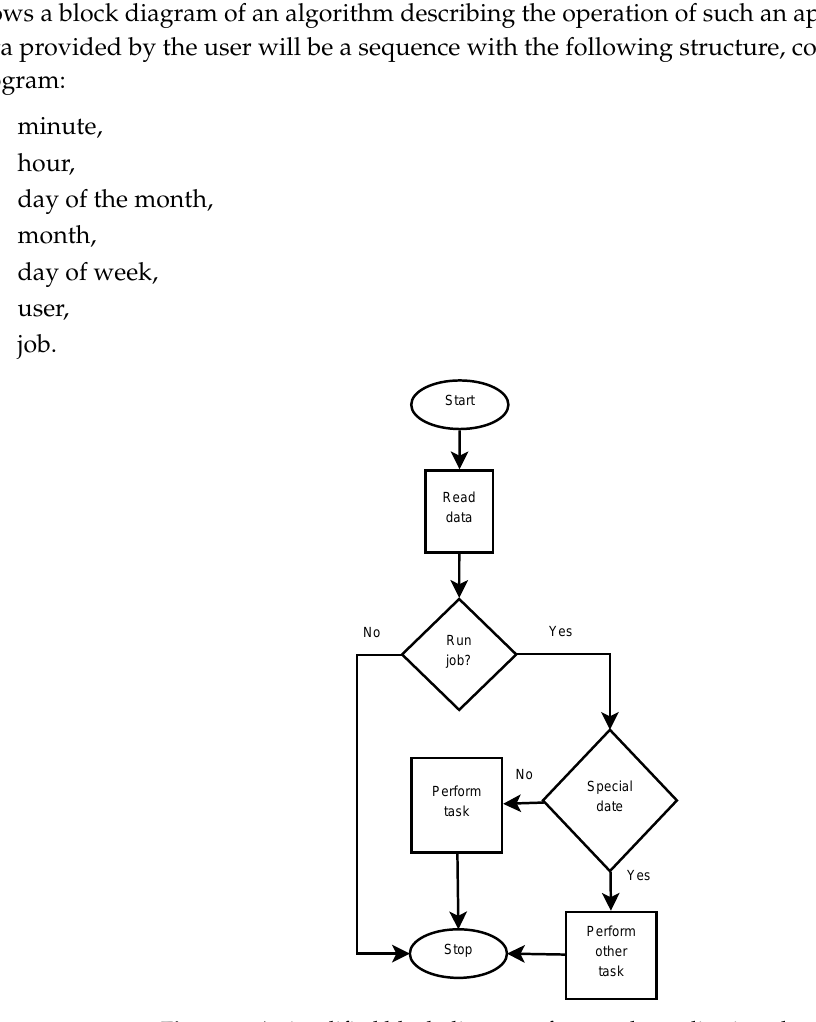
Figure 7. A simplified block diagram of a sample application